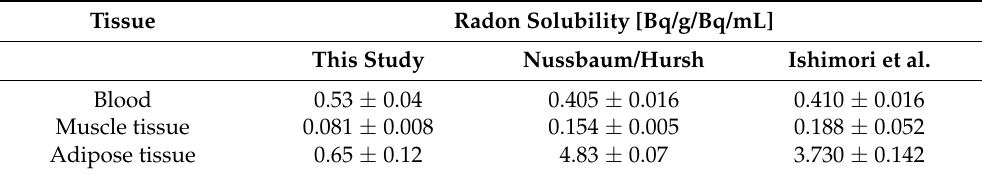
Table 4. Radon solubility data obtained in this study compared to literature data from Nussbaum/Hursh [12] and Ishimori et al. [13]. Tissue Radon Solubility [Bq/g/Bq/mL] This Study